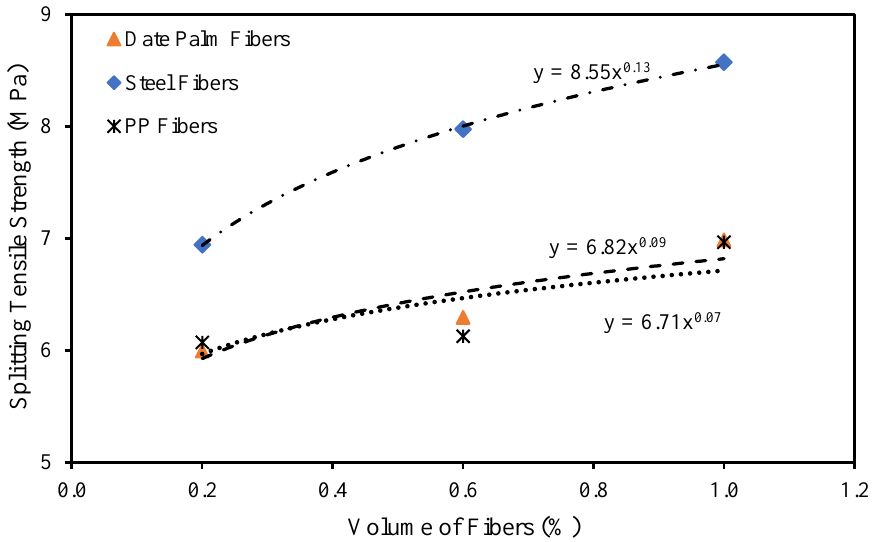
Figure 9. Relationship between the splitting strength and volume fractions for different fibers.